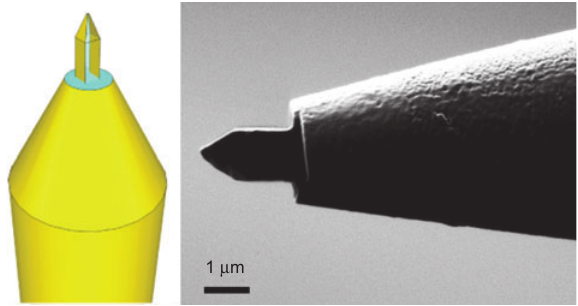
Figure 6 “ Campanile ” probe tip schematics and SEM image. Images courtesy of A. Weber-Bargioni [78] .